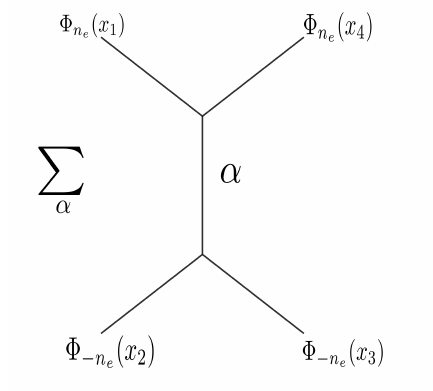
Figure 3: Galilean conformal block expansion of a four-point twist correlator in the t -channel. The choice of channel corresponds to two operators interchanging a GCA highest weight representation with the other two. The exchanged representation is labeled by α which denotes primary operators in the